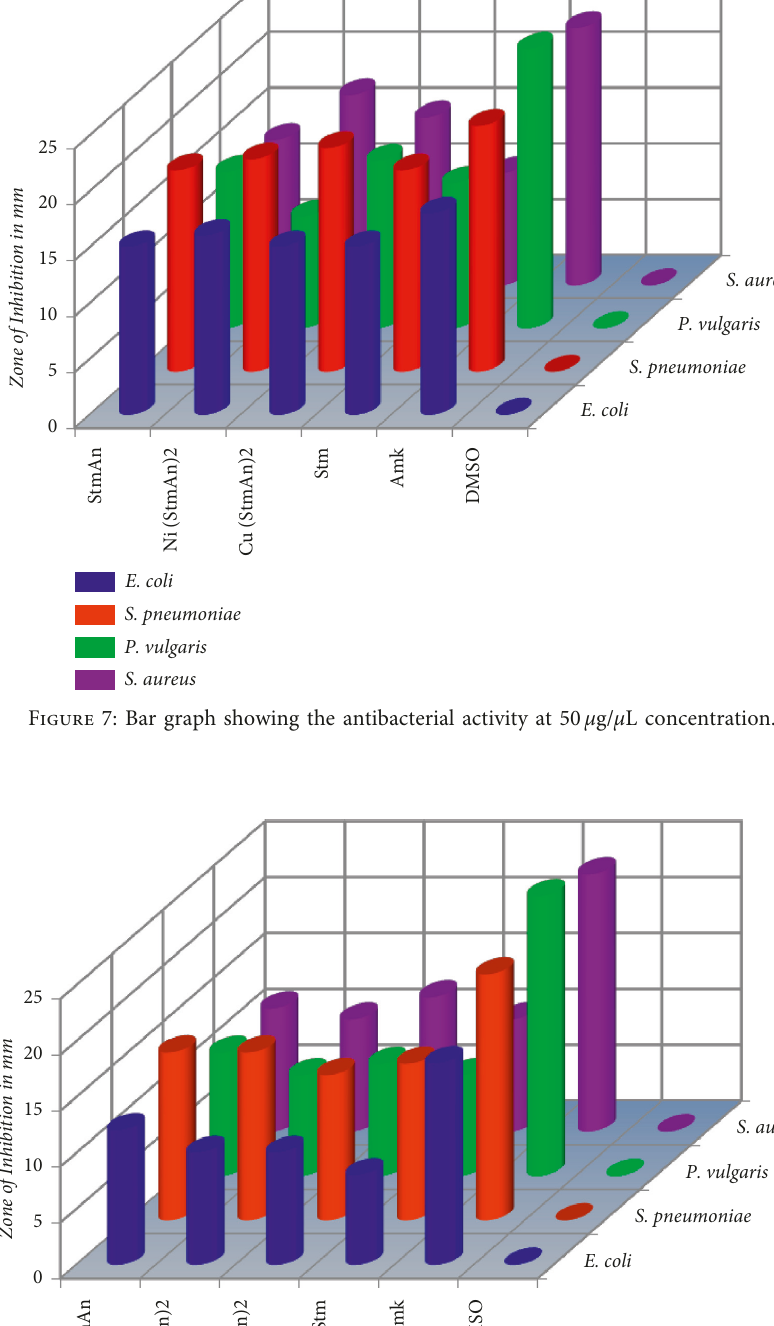
pneumoniaeP. coliS. E.